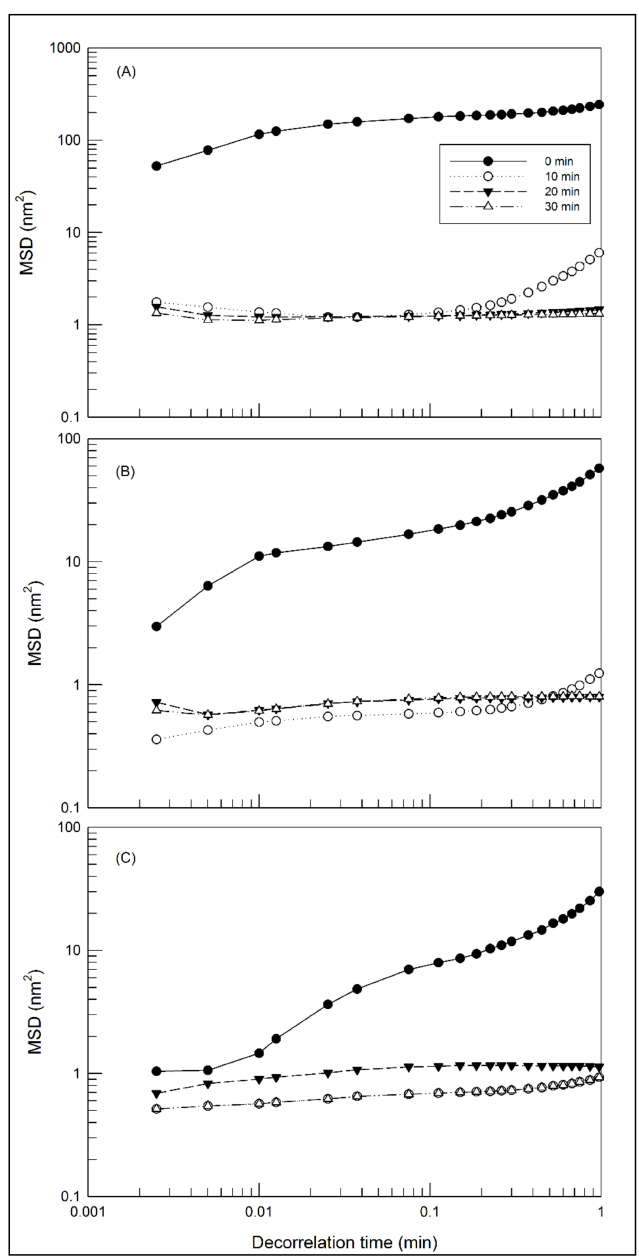
Figure 3. Mean square displacement MSD of hydrogel prepared with di ff erent concentrations of poloxamer 407: 20% ( w / w ) ( A ), 25% ( w / w ) ( B ) and 30% ( w / w ) ( C ), as a function of decorrelation